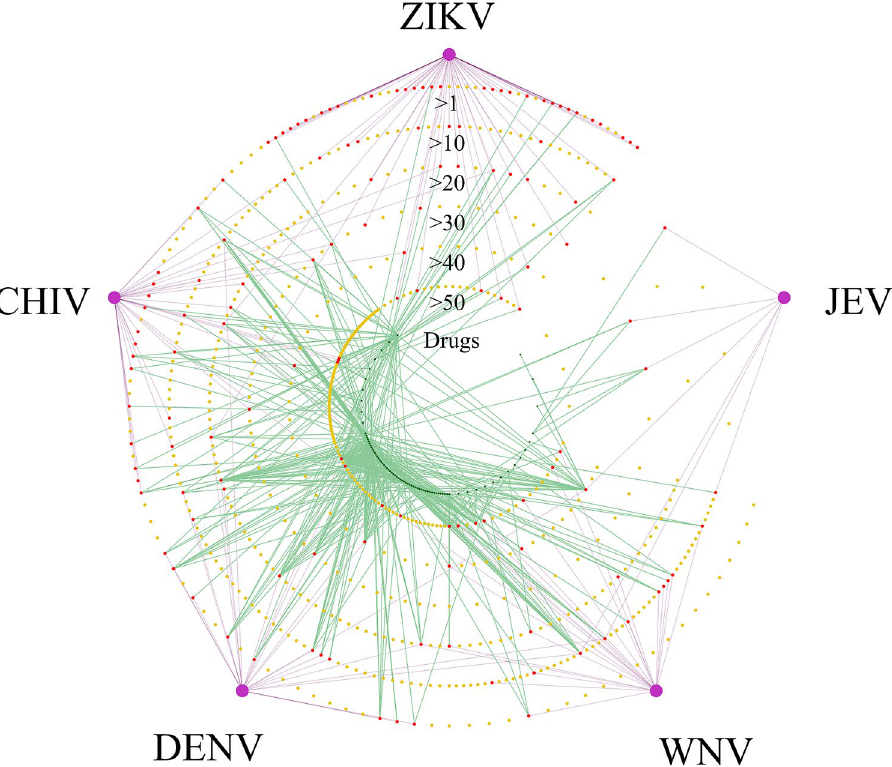
Figure 5. The network shows the relationship among drug candidates, signature proteins and the five viruses. The concentric circles show the network of diseases (purple circles), proteins (red and yellow circles) and drugs (green circles). The numbers of extended signature proteins (yellow) for DENV, ZIKV, WNV, CHIV and JEV are 262, 351, 352, 289 and 99, respectively. The degrees of the proteins calculated from the PPI network in the HPRD are divided into 0 to 10, 10 to 20, 20 to 30, 30 to 40, 40 to 50 and 50 or greater. The circularly distributed proteins with smaller radii indicate higher degrees. The numbers of common (red) and extended (yellow) proteins counting from the outer circle inwards are 32, 34, 40, 46, 48 and 57 for common proteins and 47, 54, 71, 94, 116 and 190 for extended proteins. The purple edge shows the connection between the disease and common proteins. The green edge shows the signature protein-drug candidate